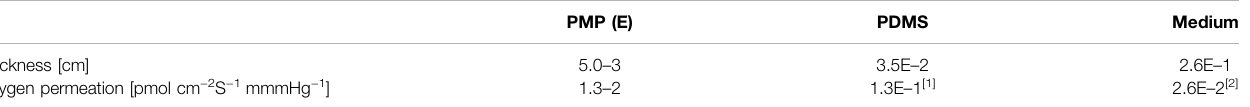
TABLE 2 | Parameters for calculating OCR.